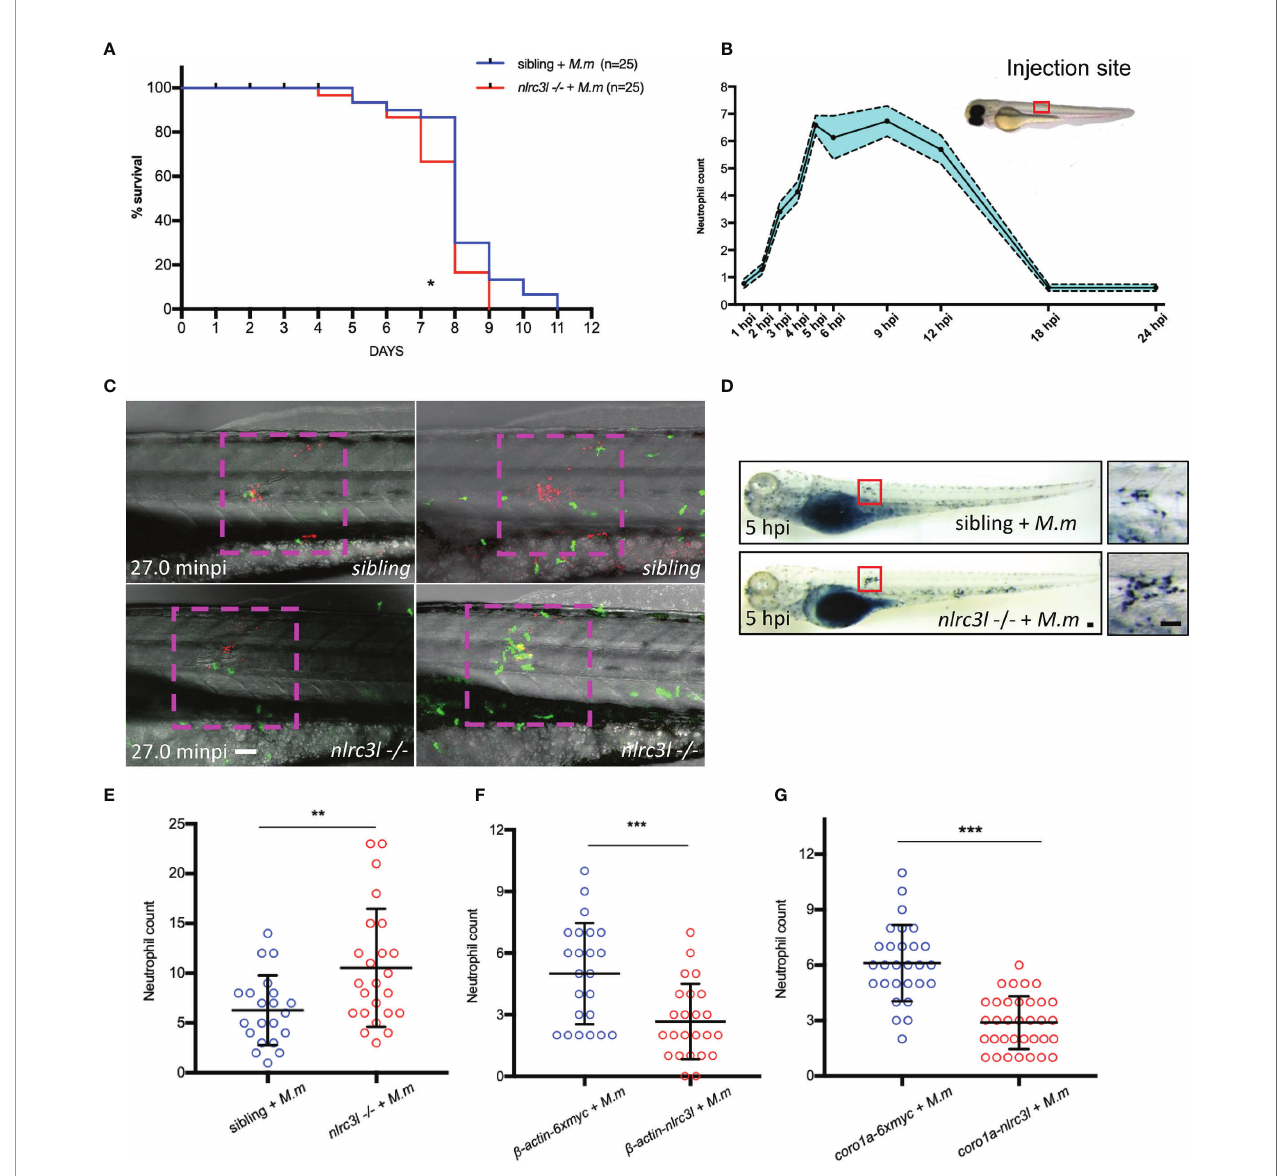
FIGURE 5 | nlrc3-like de fi ciency promotes neutrophil recruitment. (A) Survival curves of nlrc3-like -/- and non-mutant embryos after M. marinum infection, based on results from two independent biological replicates. (B) Numbers of neutrophils recruited to infection sites at the indicated time points. (C) Live imaging of neutrophils after M. marinum infection. 3 dpf Tg (lyz-GFP) zebra fi sh embryos were infected with M. marinum:Tdtomato . Time interval, 1 min 30 s. The data is representative of three independent biological replicates. (D) SB staining showing neutrophil recruitment to infection sites. The left panel shows the whole embryo while the right panel shows magni fi cation of the area in the red box used for counting neutrophils. (E) Graph of neutrophils counted in (D, F) Graph of the neutrophils counted after SB staining of b -actin-nlrc3l (whole body expression of nlrc3-like ) and b -actin-6Xmyc embryos. (G) Graph of neutrophils counted after SB staining in coro1a-nlrc3l (myeloid expression of nlrc3-like ) and coro1a-6Xmyc embryos (C, D) . Scale bar = 50 m m *p ≤ 0.05; **p ≤ 0.01; ***p ≤